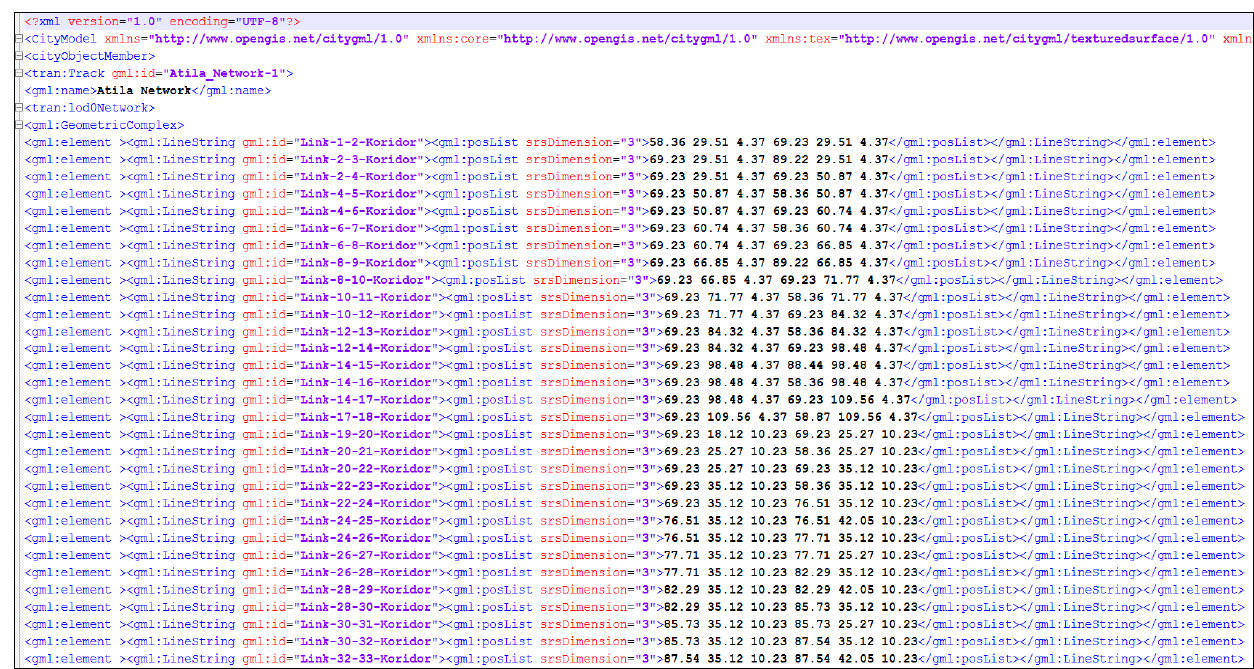
Figure 11. Network model represented in LOD-0 linear network in CityGML